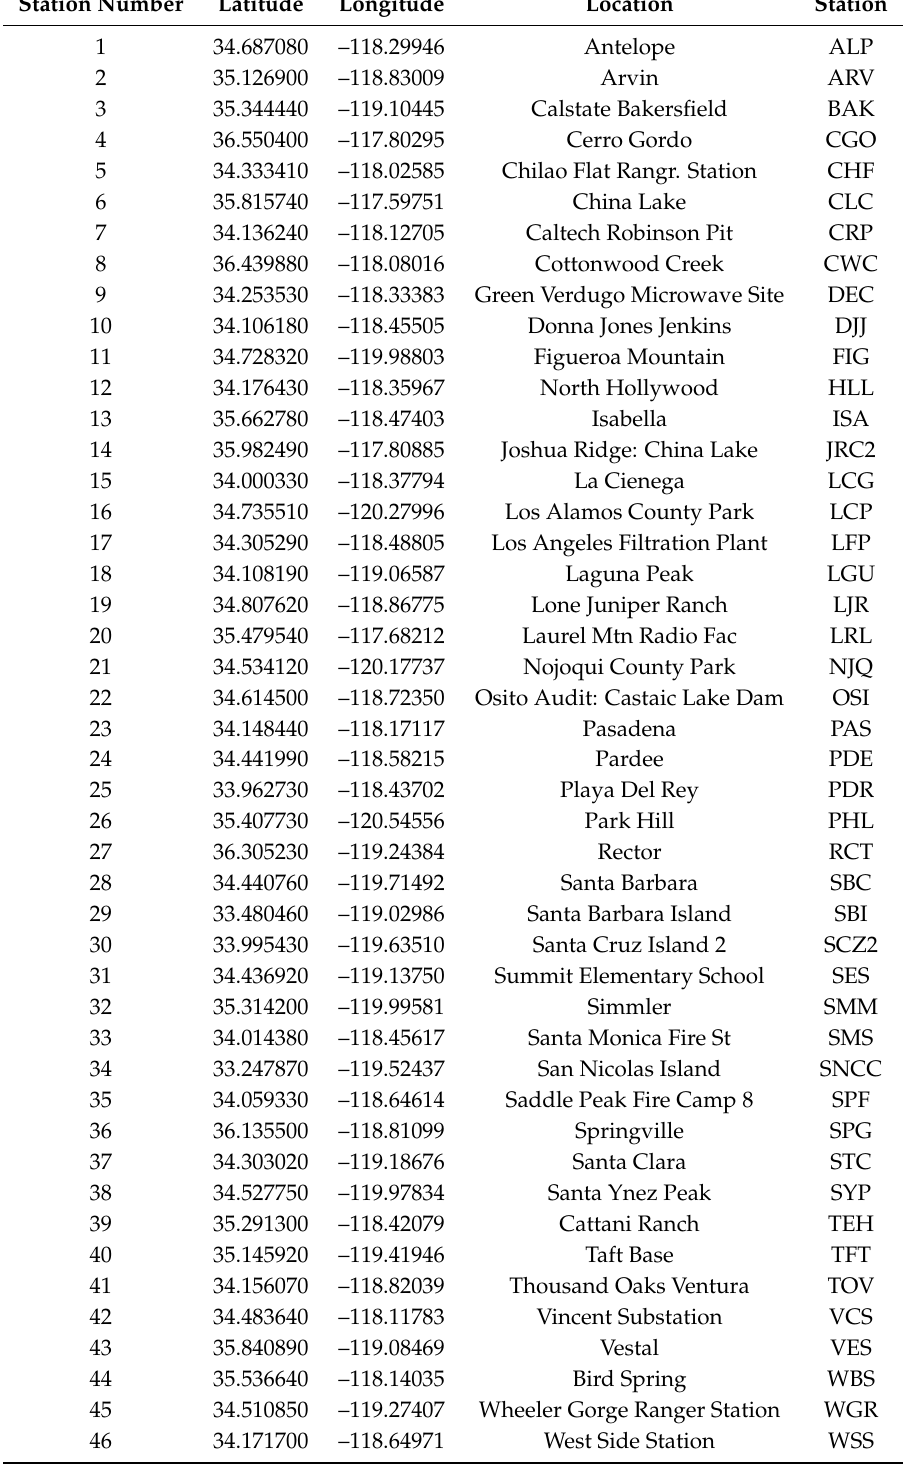
Table A2. List of stations, latitude, longitude, location, and station ID whose data is used for the 2004 Parkfield earthquake simulation. All stations belong to the Southern California Seismic Network (FDSN code: